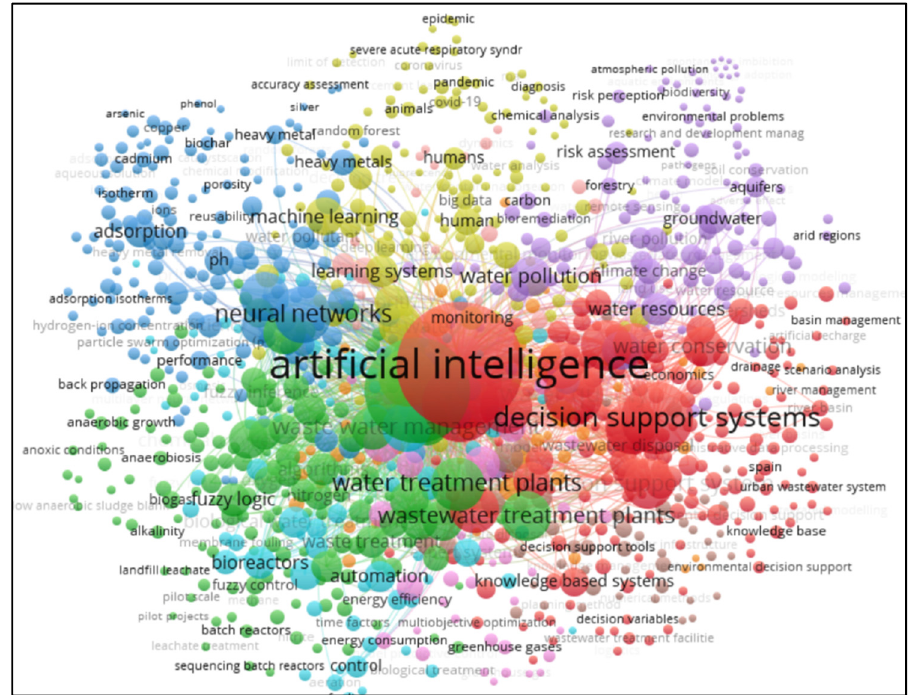
Figure 1. The major keywords used over the literature on desalination and AI-based models (1984– January 2023).